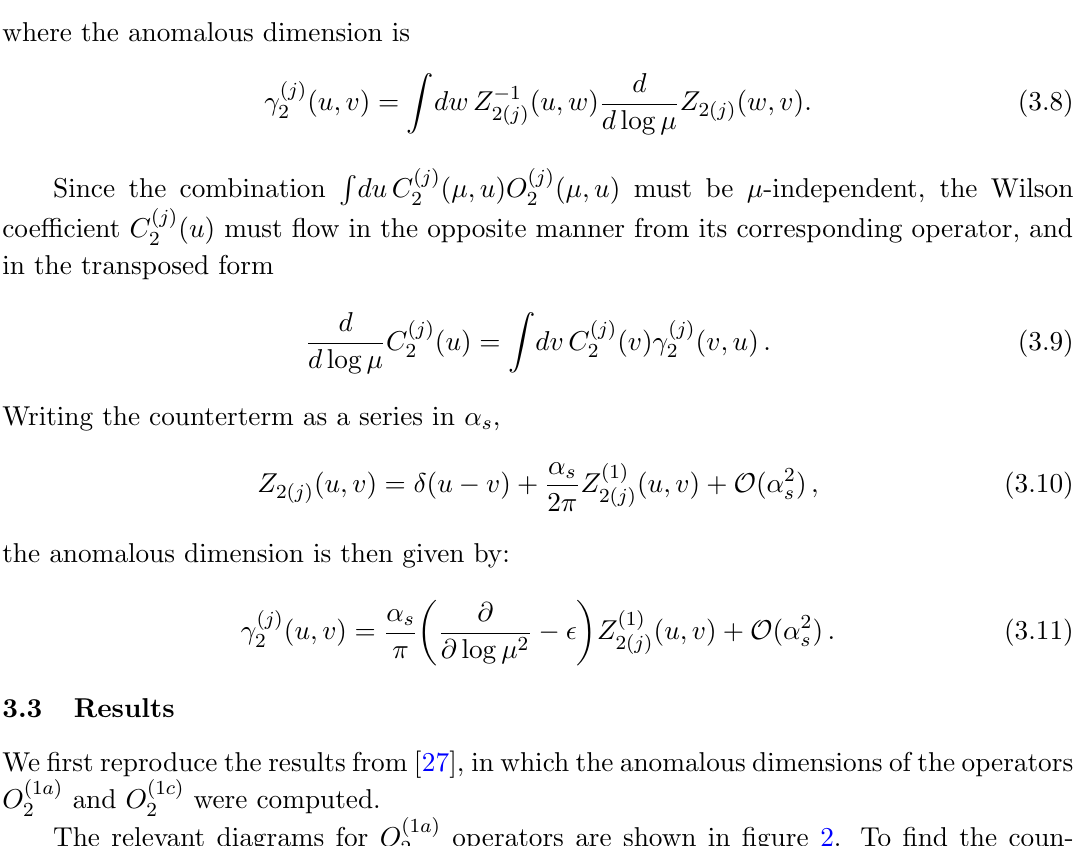
Figure 2 . The Feynman diagrams for any operator with the q n (cid:22) q (cid:22) n g n con(cid:12)guration. The Feynman rules for the e(cid:11)ective vertex are determined by the structure of each operator. Diagram (g) is the overlap amplitude, and must be